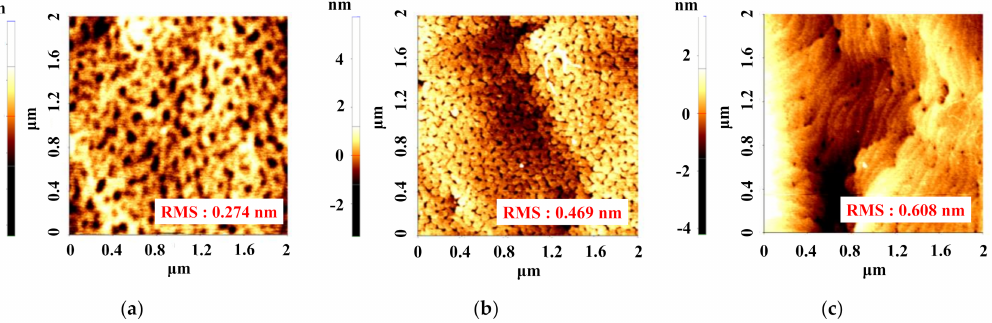
Figure 3. AFM images of AlGaN/GaN HEMTs with ( a ) SiCN and ( b ) SiN cap layer compared to ( c ) without cap layer including the root mean square (RMS) roughness values on 2 × 2 µ m scan